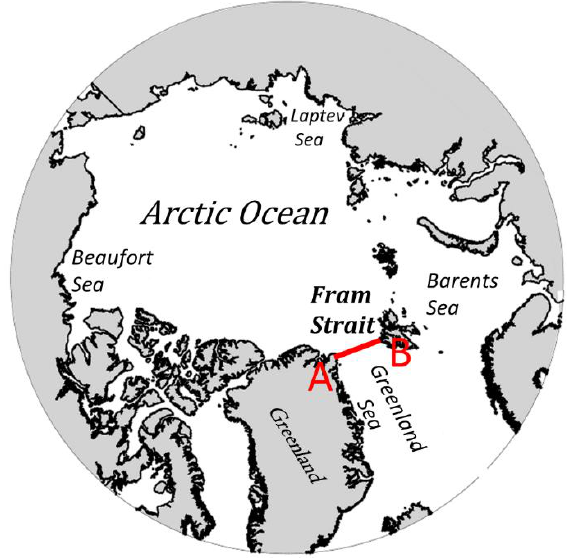
Figure 1. Location of the FS is marked by the red bold line. The studied area comprises a gate connecting point A (11°W, 81.7°N) of Greenland and point B (10.1°E, 79.7°N) of Svalbard.